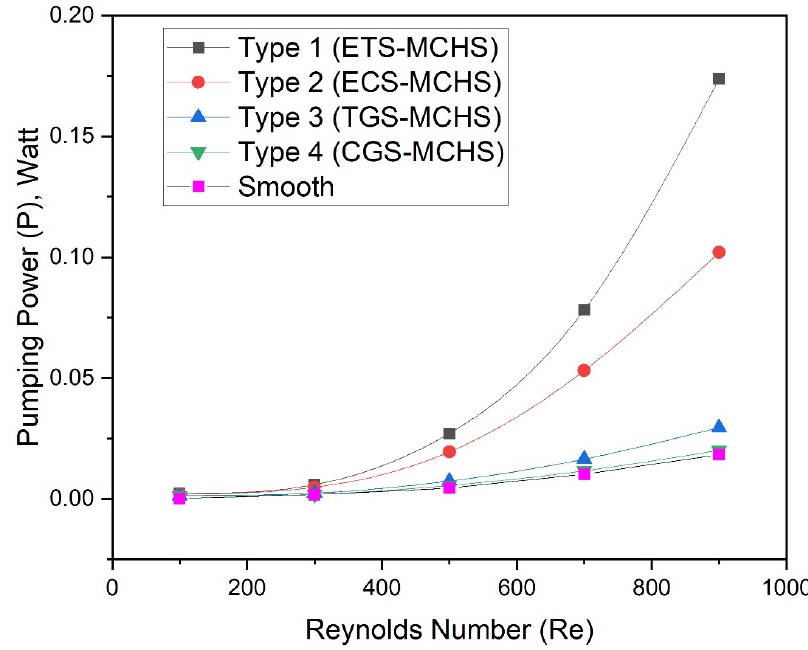
Figure 11. Plots of friction factor with Reynolds numbers for different angles.